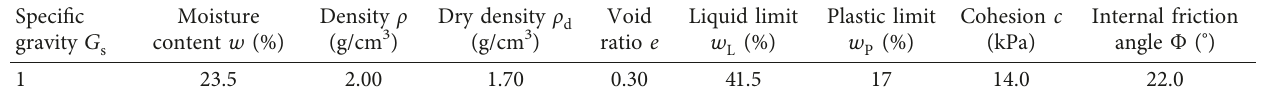
Table 1: Basic physical parameters of slide